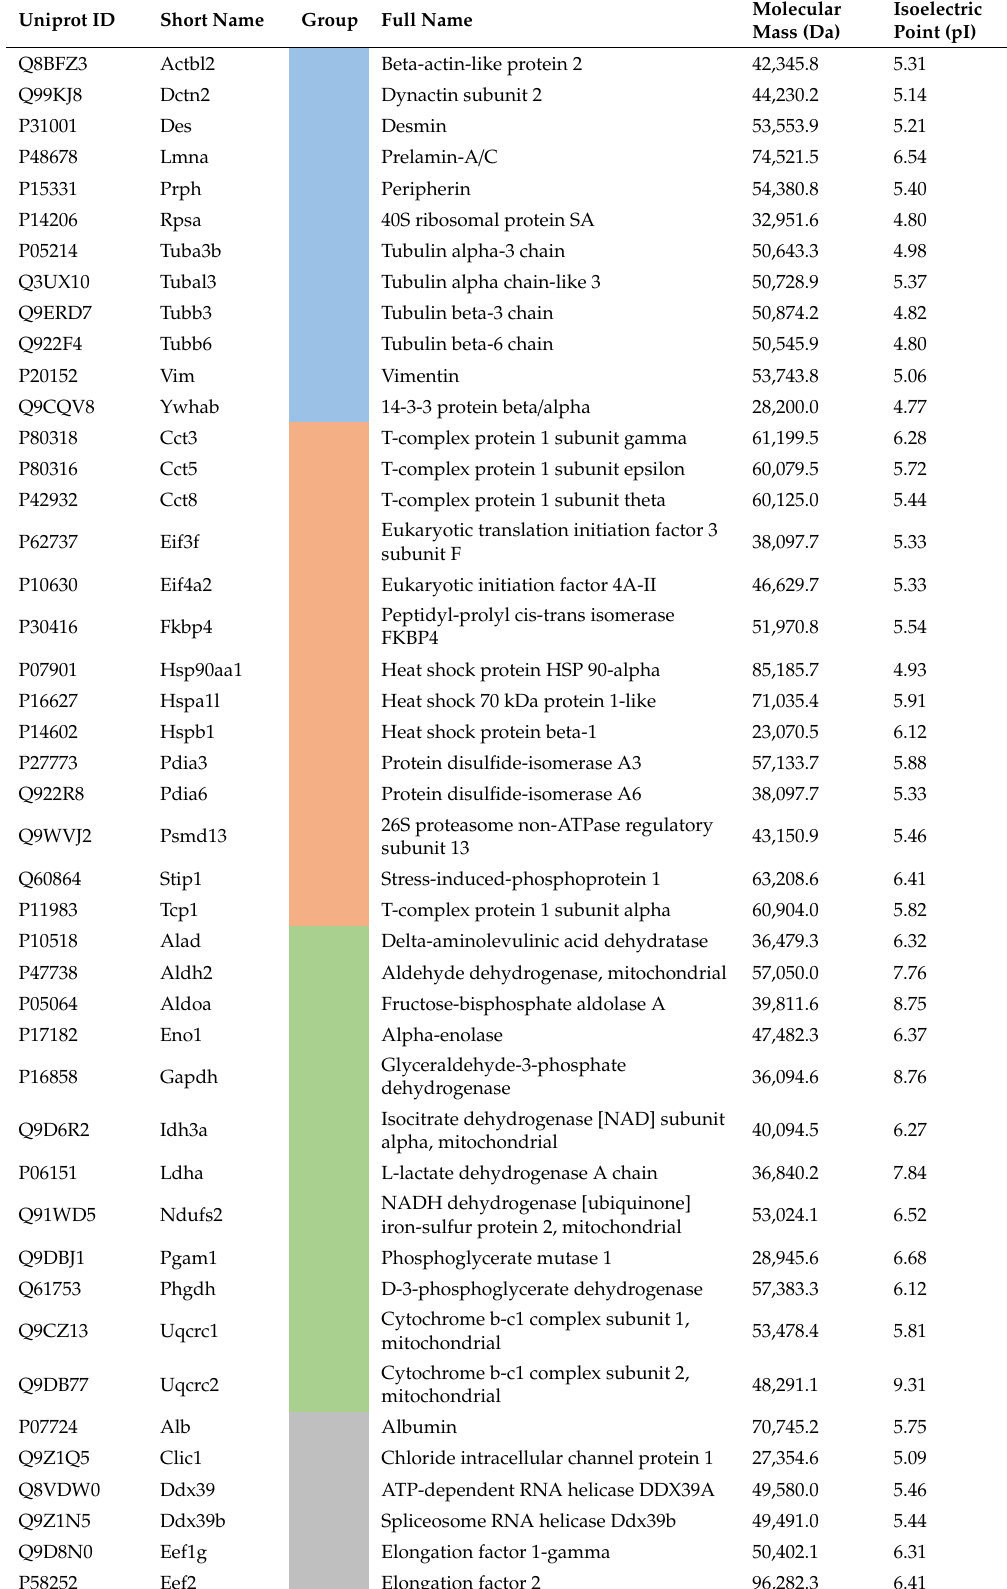
Table 1. 2-ClHDyA-modified proteins identified in whole cell lysates of HL-1 cardiomyocytes. Only proteins identified in two out of three gels are